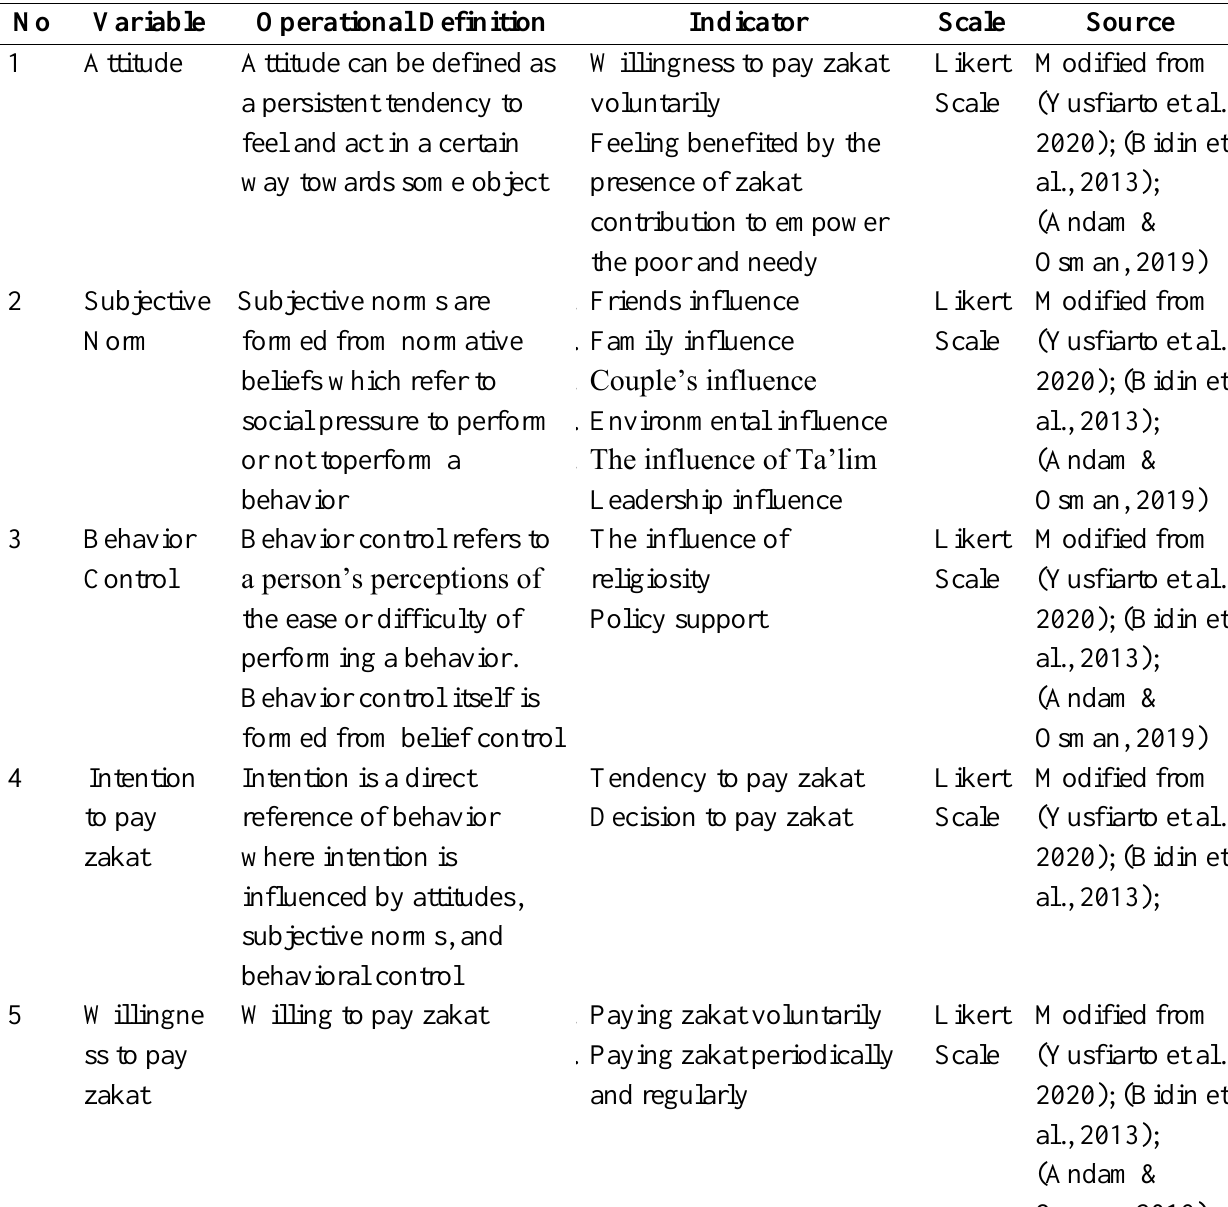
Table 2: Operational